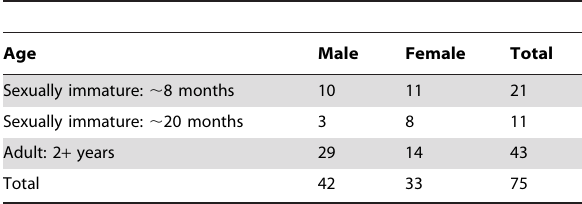
Table 1. Age and gender classification for sampled E. helvum annobonensis.